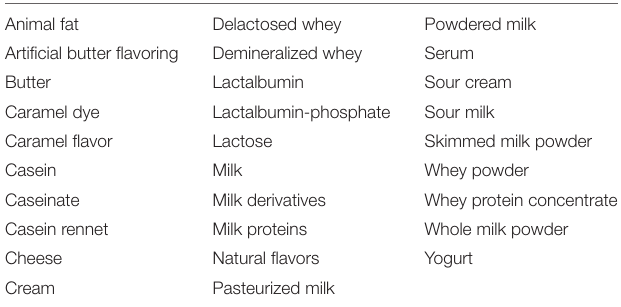
TABLE 1 | Labels terminology that may indicate the presence of cow’s milk proteins. Animal